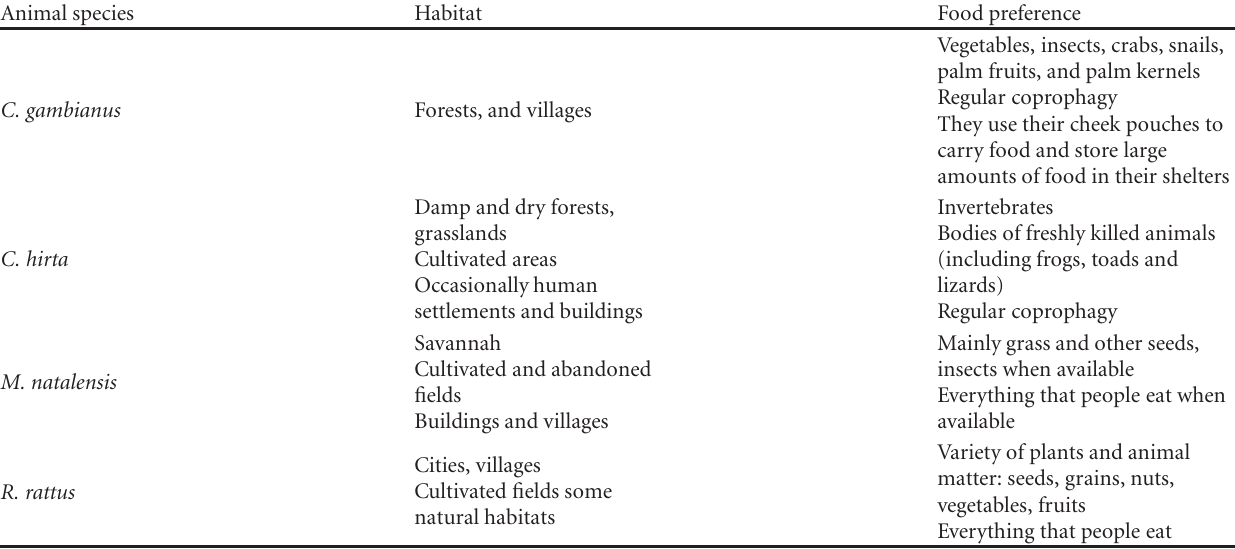
Table 7: Habitat and food preference of the main animals species collected according to Nowak